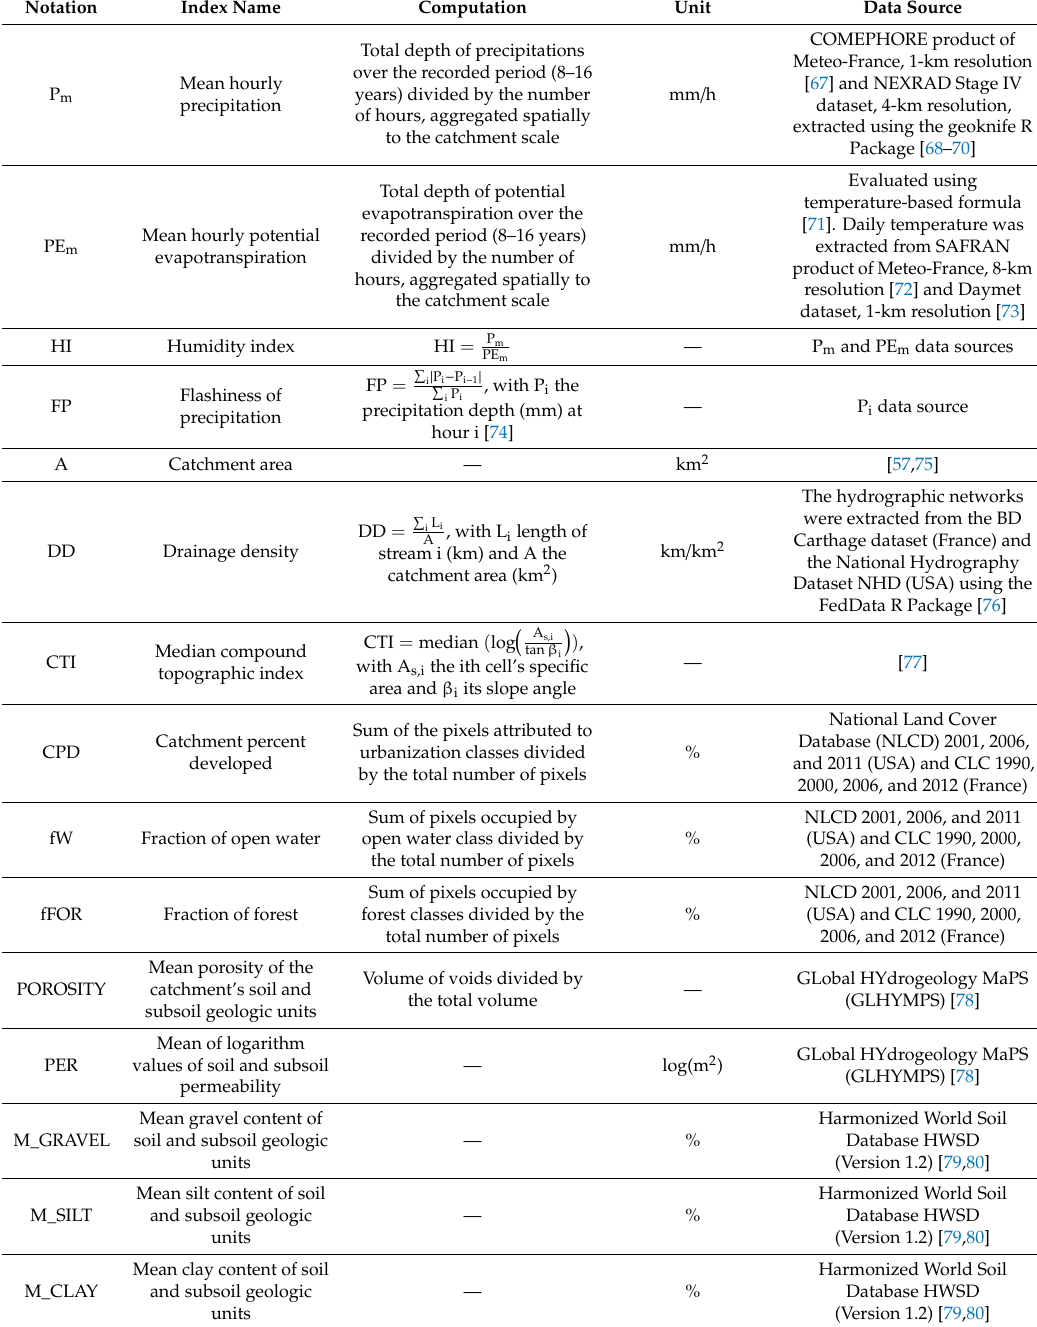
Table 1. Description of the di ff erent climatic, topographic, land-use, and geopedological characteristics estimated for each